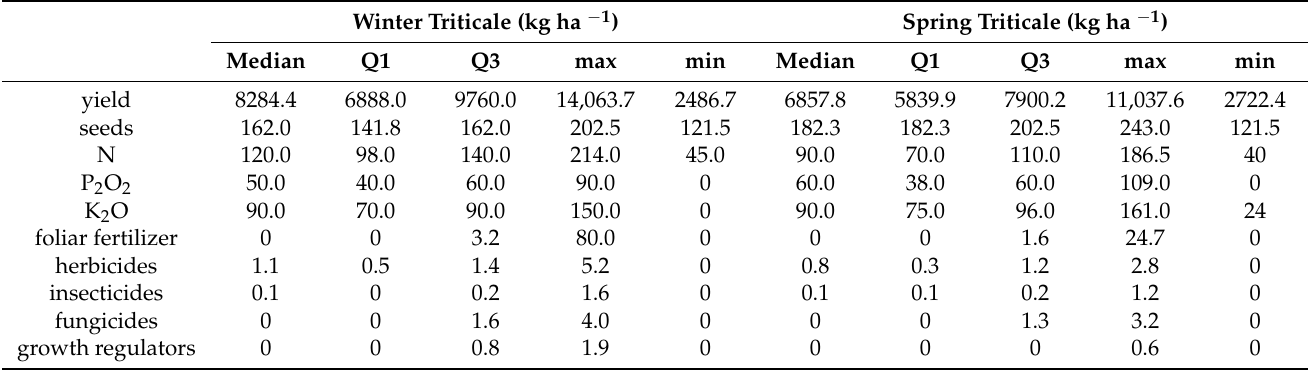
Table 1. Medians, the first and third quartiles and minimum and maximum values for quantitative variables related to triticale